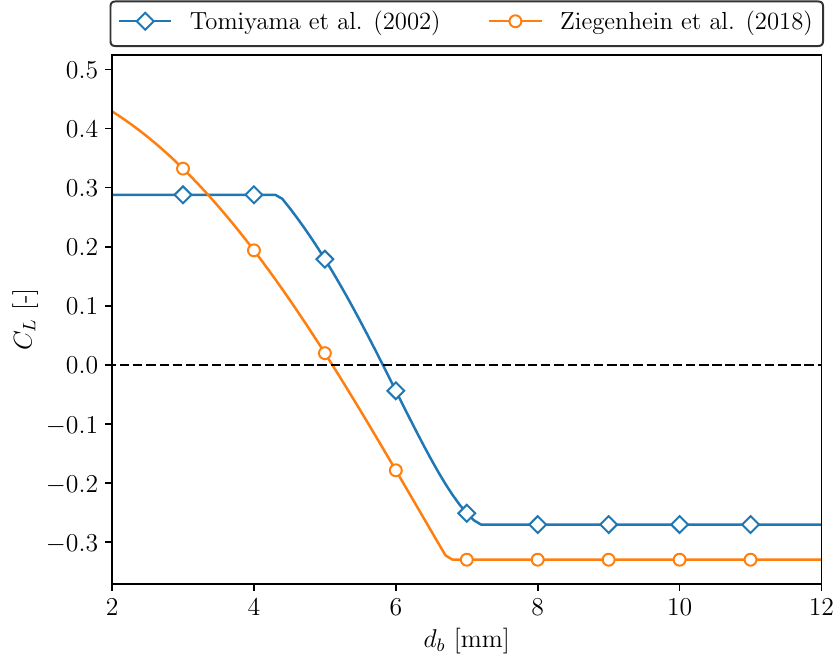
Figure 9. Comparison between Tomiyama et al. (2002b) [32] and Ziegenhein et al. (2018) [34] models for the lift